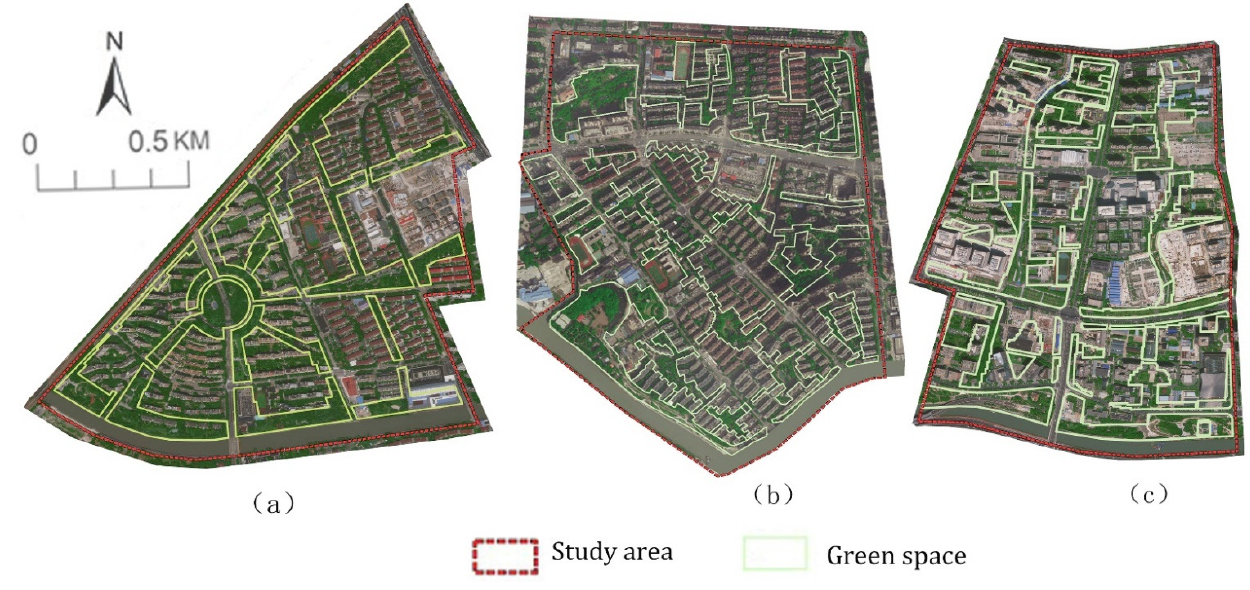
Figure 2. Satellite images and green space patterns of the three study areas in 2019: ( a ) block 1 (N1), ( b ) block 2 (N2) and ( c ) block 3 (N3).